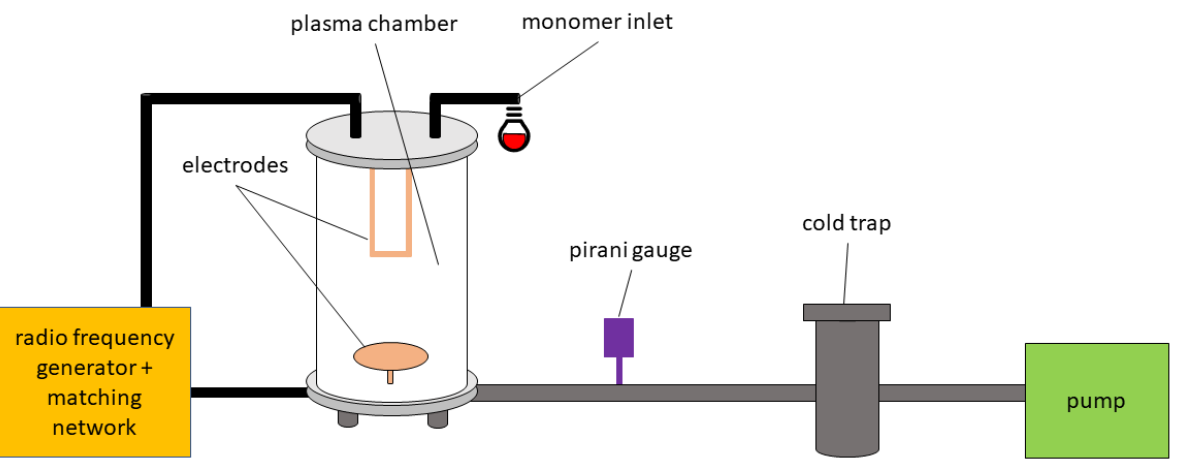
Figure 2. The layout plasma reactor’s layout; incuding the position of the RF generator, electrodes, monomer inlet, pirani gauge, cold trap and